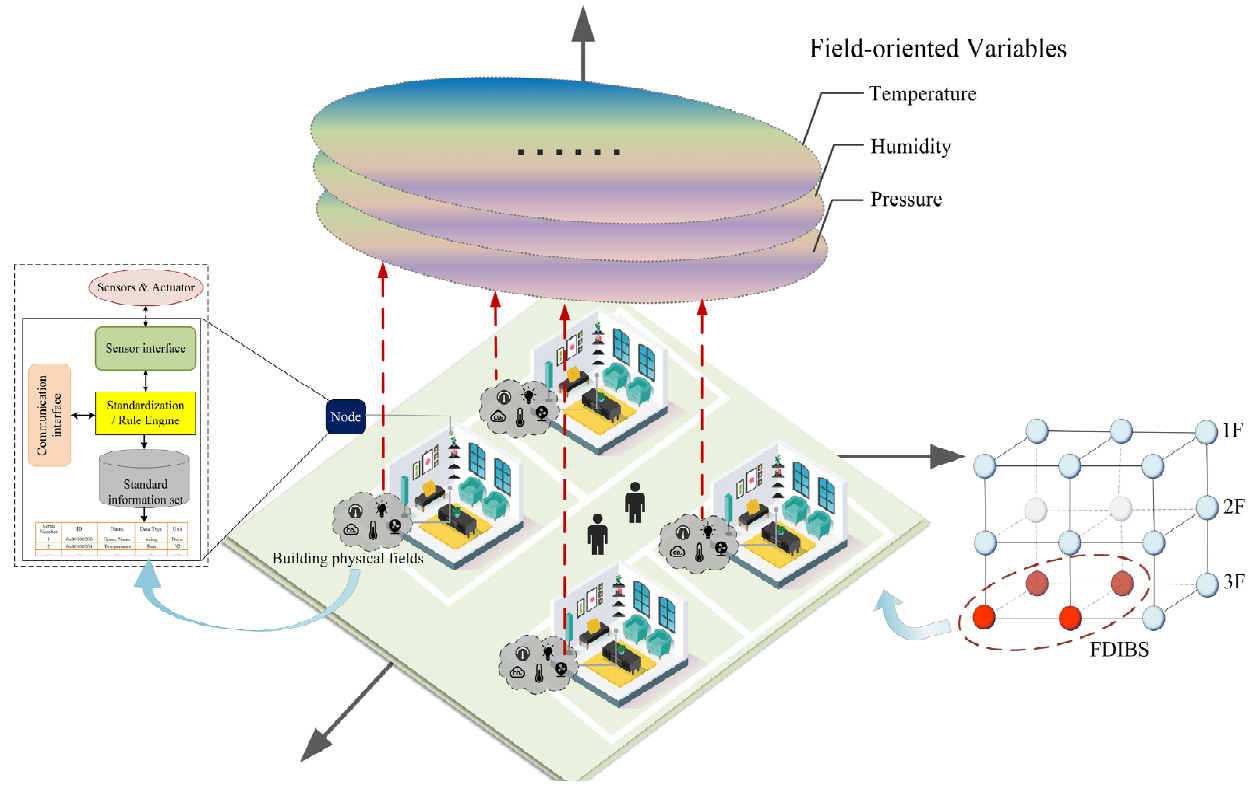
Figure 7. Field-oriented variables in the FDIBS.